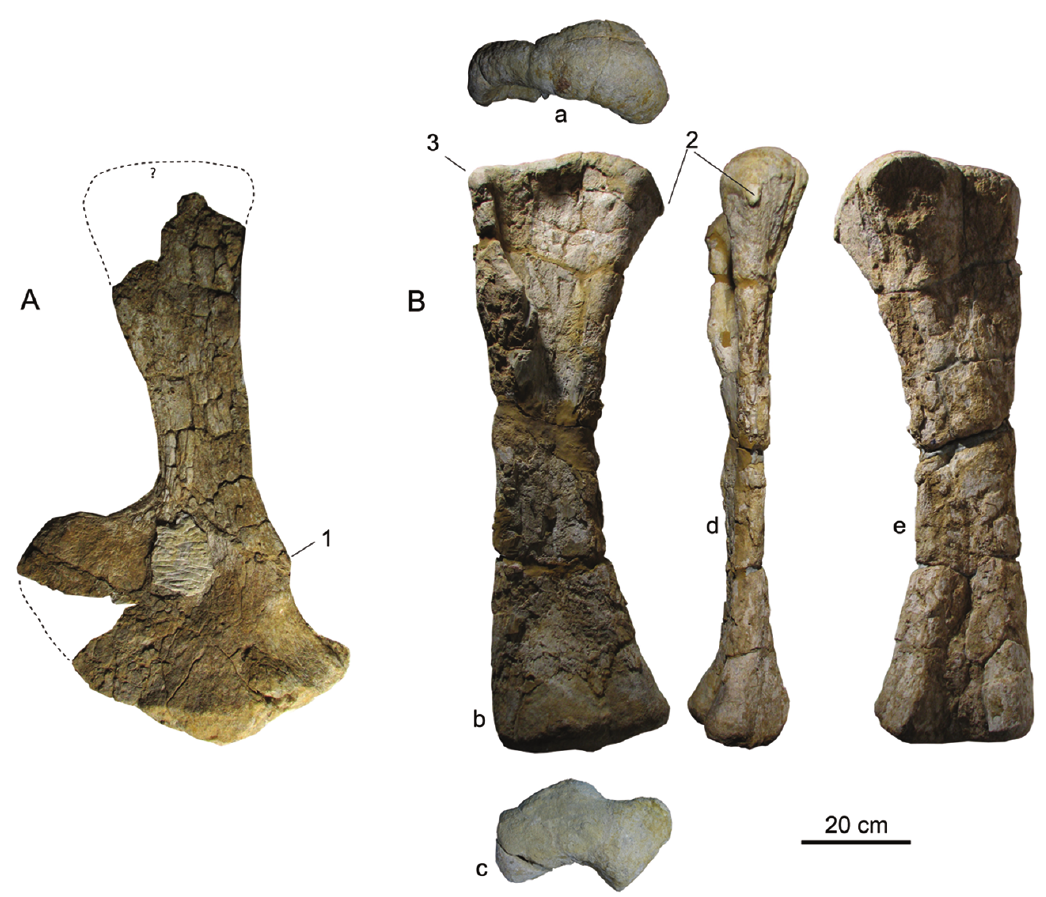
Fig. 3 – Angolatitan adamastor n. gen. et sp., A) right scapula in medial view; B) right humerus in proximal(a), anterior (b), distal (c), medial (d), and posterior (e) views. Autapomorphic features: 1, posteroventral eminence in scapula in the proximal one-quarter, anterior to the acromial ridge; 2, acute medioproximal margin of humerus; and 3, rectangular lateral corner of proximal